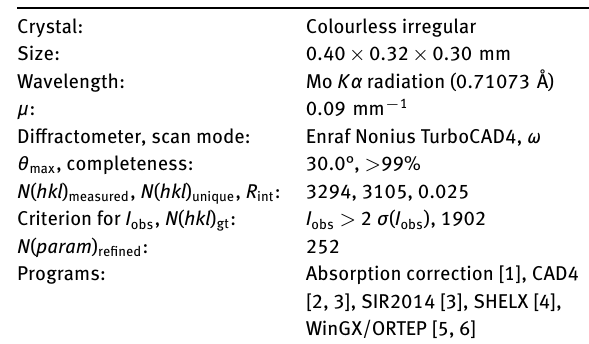
Table 1: Data collection and